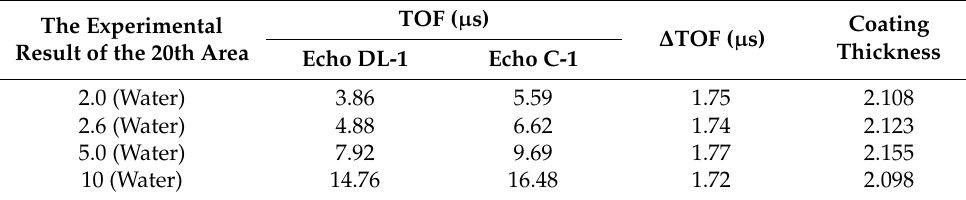
Table 2. TOF time difference in 20 areas and coating thickness measurement results.